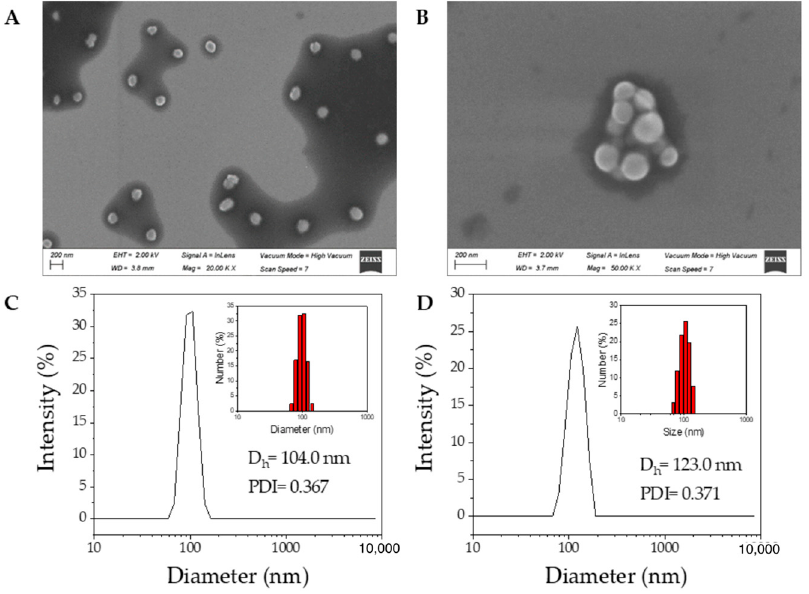
Figure 2. ( A , B ) HR-SEM images of CP1 and CP2 NPs, respectively. ( C , D ): DLS analysis of CP1 and CP2 NPs, respectively (c = 0.1 mg mL − 1 ). The corresponding histograms are shown in the insets.